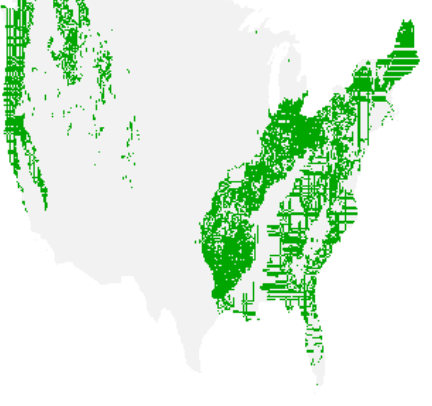
Figure 4. Overall result of divergence change for precipitation pattern